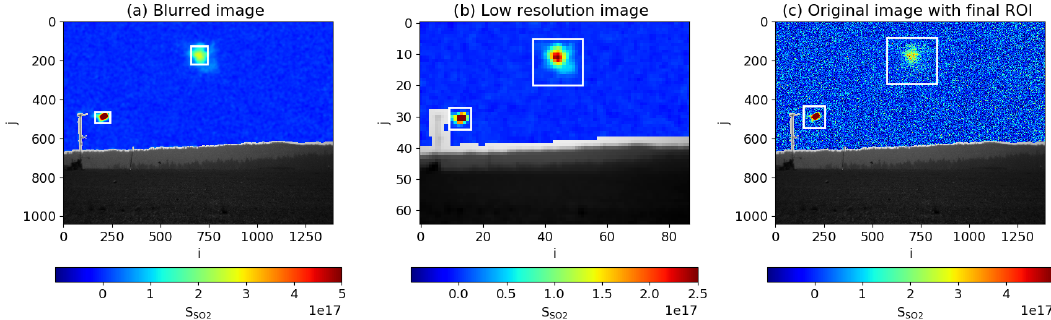
Figure B2. Puff detection based on noise-reduced images, here for camera 1 at 10:30:12. The ROI is detected in a blurred image based on the position of the CM in the previous image (a) . A low resolution image is used to detect connected areas above a threshold (b) . The combination of both detections gives the resulting ROI, which is used to calculate the CM, total signal and spread in the original image (c) .